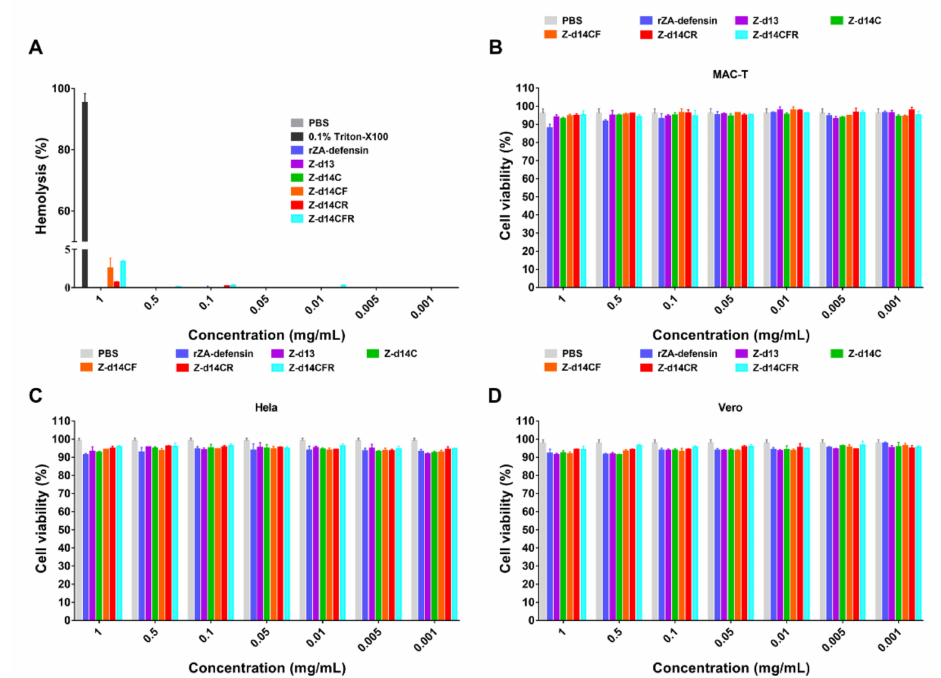
Figure 3. Hemolysis and cytotoxicity of rZA-defensin and its analogues. ( A ) Hemolysis of rZA- defensin defensin and its analogues. ( B – D ) Cytotoxicity of rZA-defensin defensin and its analogues to MAC-T ( B ), Hela ( C ), and Vero ( D ). The results are represented as mean ± SEM from three independent